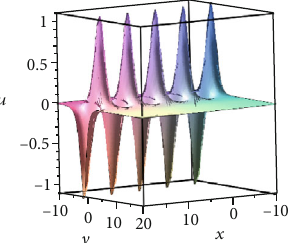
Figure 4: Spatiotemporal structure of solution (16) with the parameter selections a 2 = 1 , a 5 = 1 , a 6 = 1 , k 2 = 1 , δ 1 = 1 , δ 2 = 1 , = 1 , and δ = 1 . δ 3 5